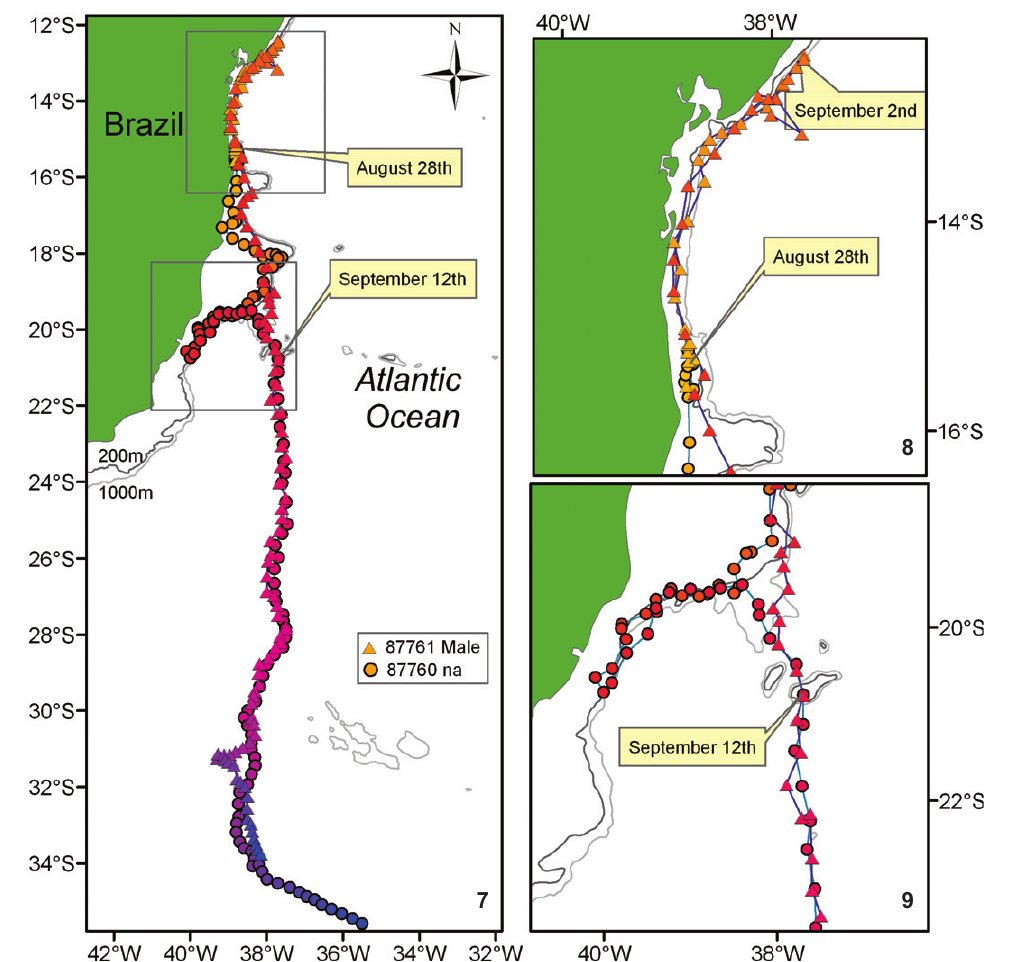
Figures 7-9. Movements of humpback whale Pair D tagged at the Brazilian breeding ground. (7) overview of the tracks; (8) tracks after deployment; (9) shows the end of the monitoring period. The same colors correspond to the same dates for each